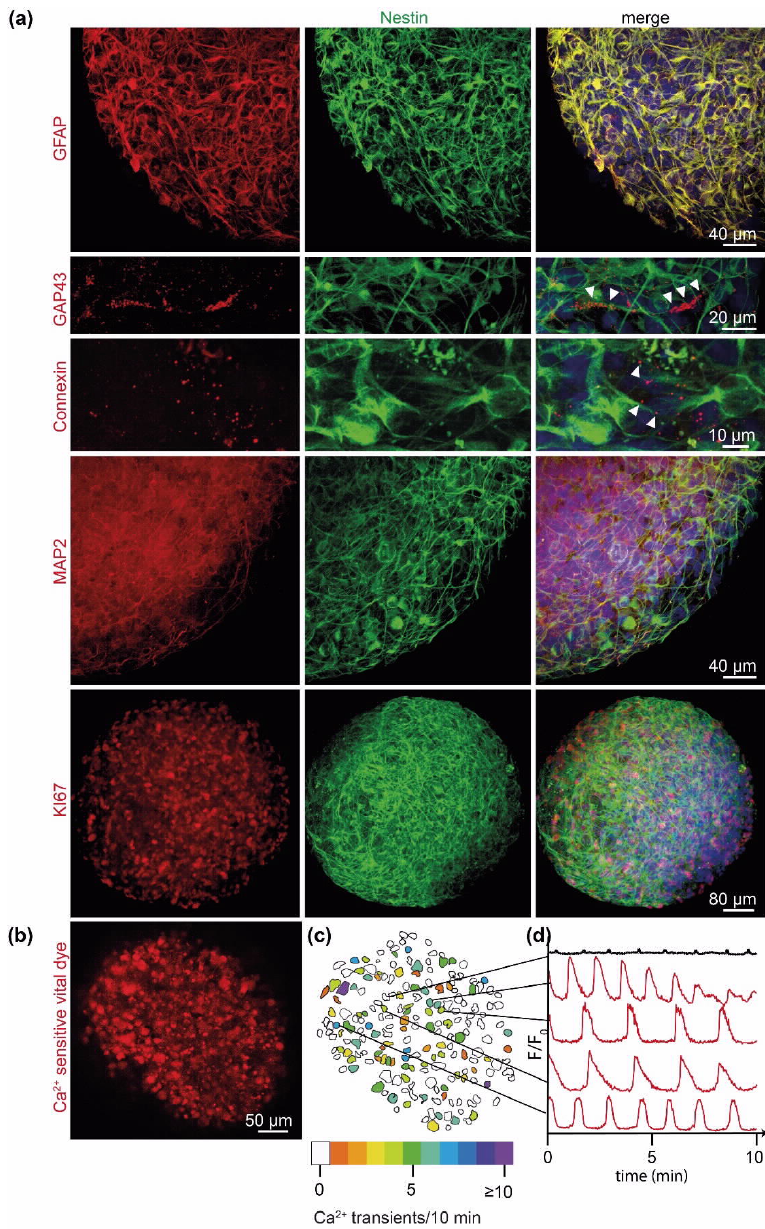
Figure 2. Patient-derived glioblastoma organoids (PD-GBOs) preserve features of glioblastoma tumor tissue. ( a ) Exemplary immunofluorescence staining proteins common to glioblastoma (see text for references): GFAP, GAP43, Connexin 43, MAP2, and Ki67 (all shown in red), nestin (green), and DNA stained with Hoechst3342 (blue). All images were acquired by confocal microscopy of PD-GBOs from patient MA03. Arrowheads mark GAP43 and Connexin 43 found alongside TMs, as observed in human glioblastoma tumor tissue [14]. TM connections facilitate communication in multicellular networks [13–18]. ( b – d ) PD-GBO cells transmit calcium transients (image and data from Supplemental Movie S1). ( b ) Optical section from a representative 14 day old PD-GBO after incubation with fluorescent mitochondrial dye (Rhod-2 AM) to visualize calcium transients. ( c ) Tracing of cell bodies from ( b ) and color-coding to identify and discriminate participating cells on the basis of frequency of calcium transients within a representative 10 min time period. ( d ) Chart of calcium transients ( ∆ F/F0) of individual, but TM-connected tumor cells identified in ( c ). Note the absence of calcium transients in a nonparticipating cell (top black line). Calcium transients travel along TMs of glioblastoma tumor cells, leading to synchronous calcium peaks in TM-connected cells